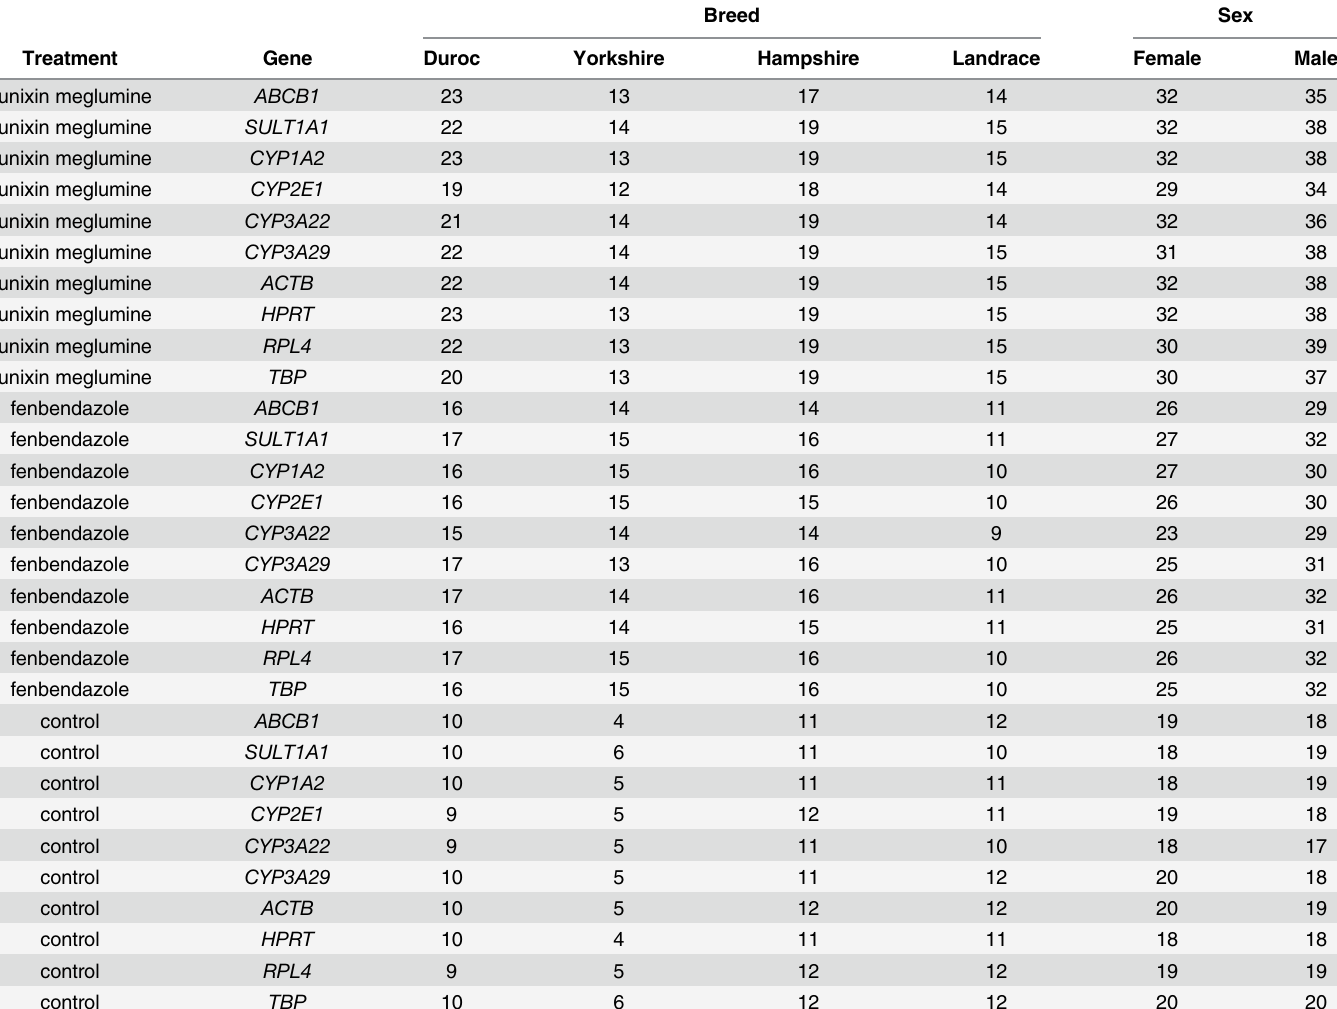
Table 1. The number of animals by breed and sex for flunixin meglumine, fenbendazole and the control used in the final analysis across target and housekeeping genes 1 .